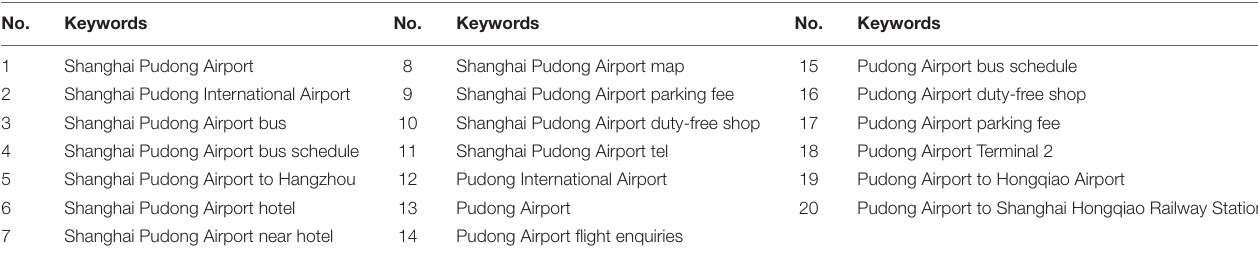
search data simultaneously, and the corresponding sub- sequence groups are obtained. For each group of sub- sequences, BiLSTM model is established to predict the corresponding airport passenger volume